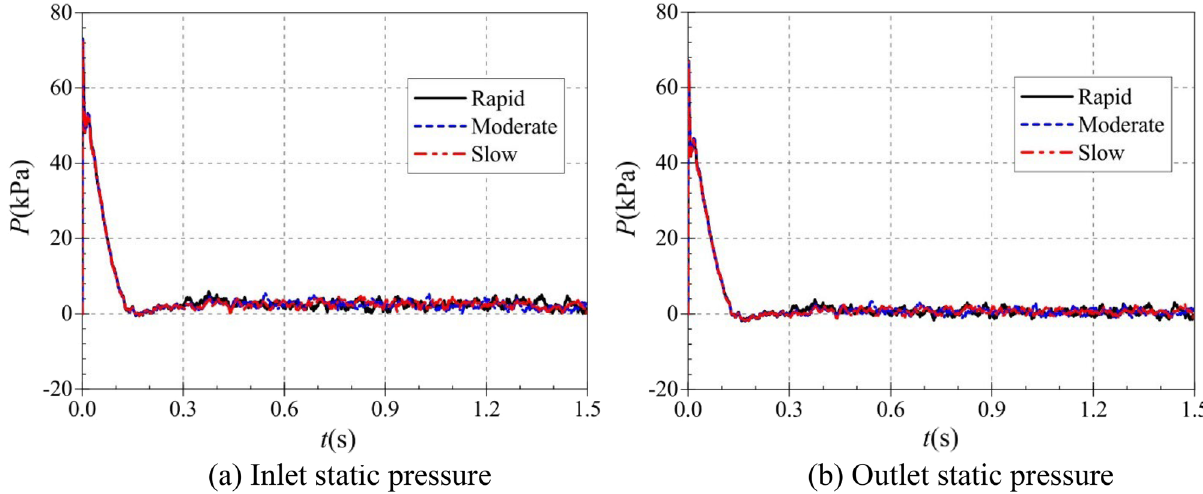
Figure 26. Instantaneous static pressure rise characteristics at different operating conditions. ( a ) Inlet static pressure, ( b ) Outlet static